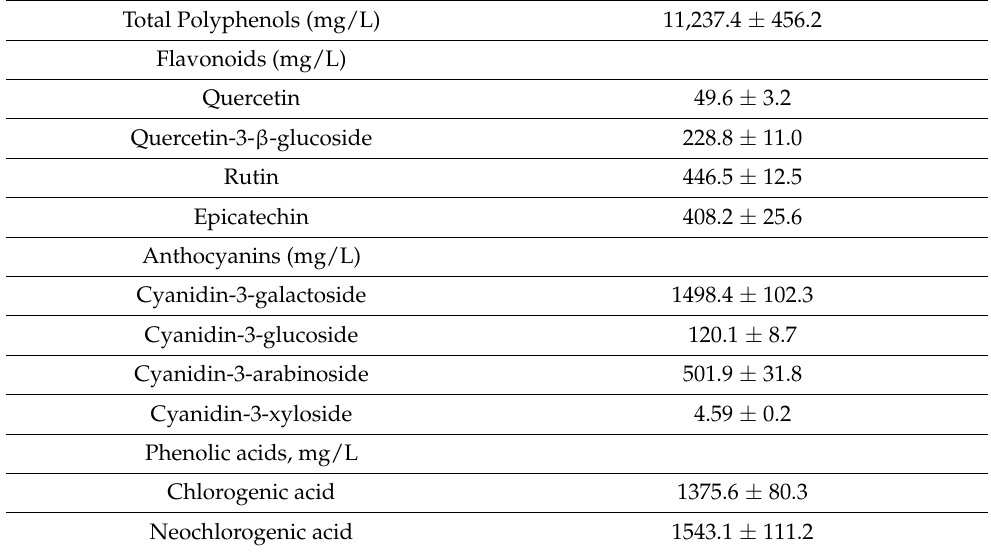
Table 1. Content of anthocyanins and other phenolic compounds in A. melanocarpa fruit juice